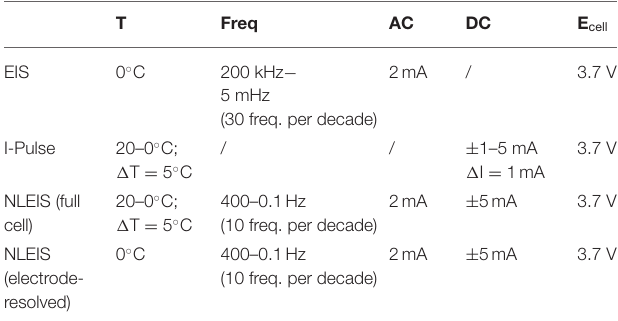
TABLE 2 | Experimental parameters for EIS spectra, I-Pulse measurements, and NLEIS spectra as a function of temperature.